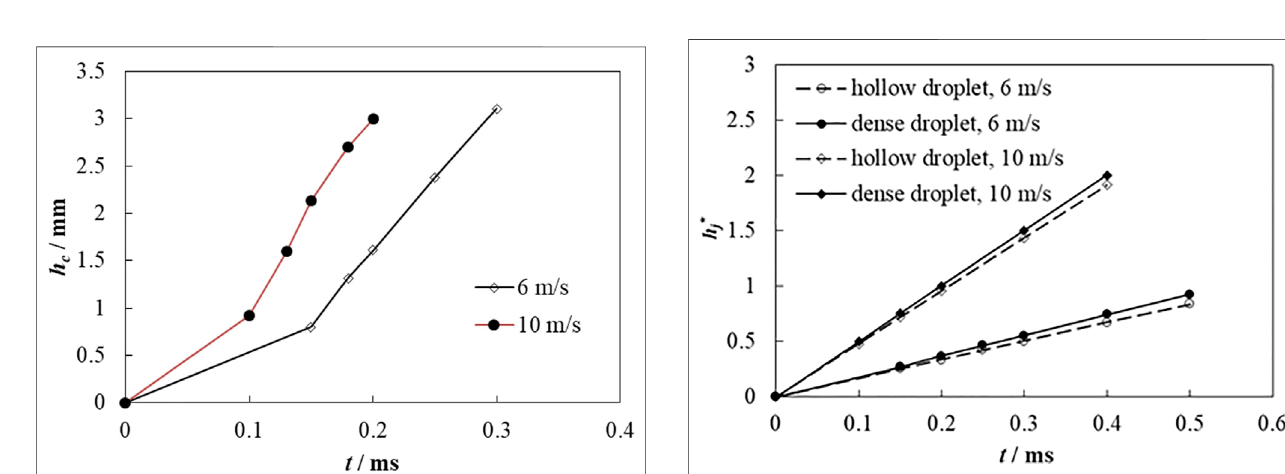
FIGURE 7 | Spreading factor of a hollow droplet and continuous dense droplet at impact velocities of 6 and 10 m s − 1 .